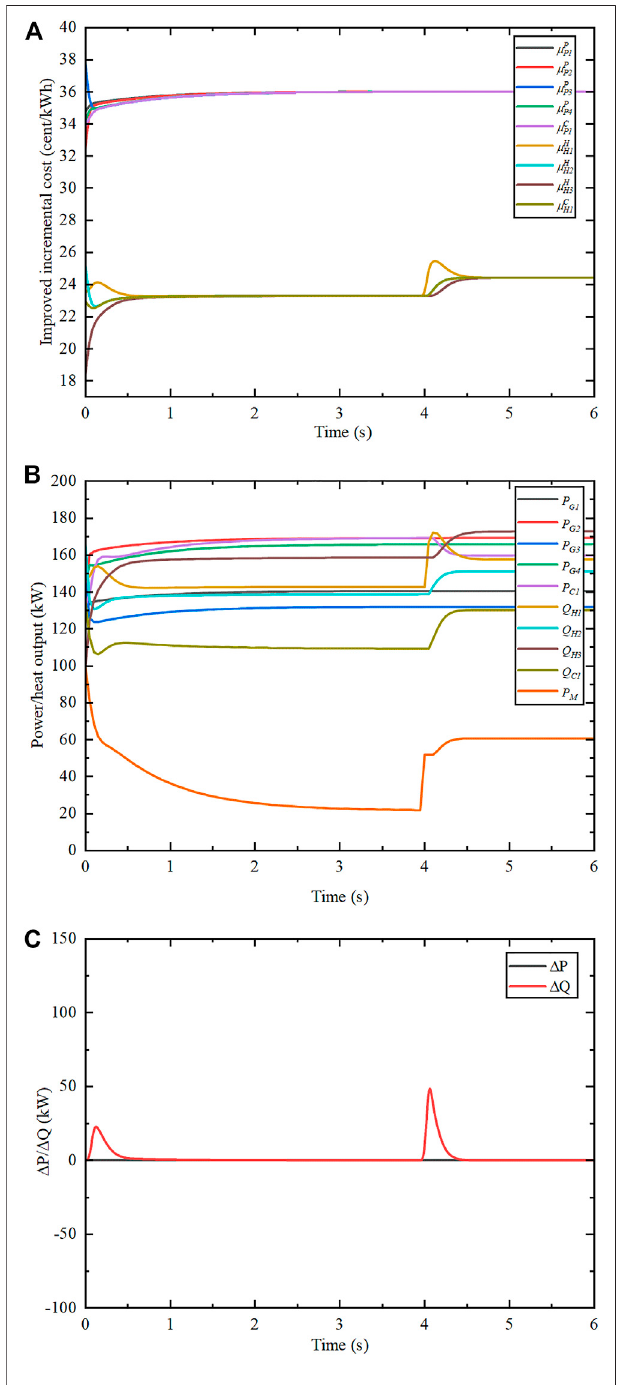
FIGURE 6 | Algorithm results in grid-connected operation mode. (A) Improved incremental cost. (B) Power output of each unit. (C) Electrical and thermal power